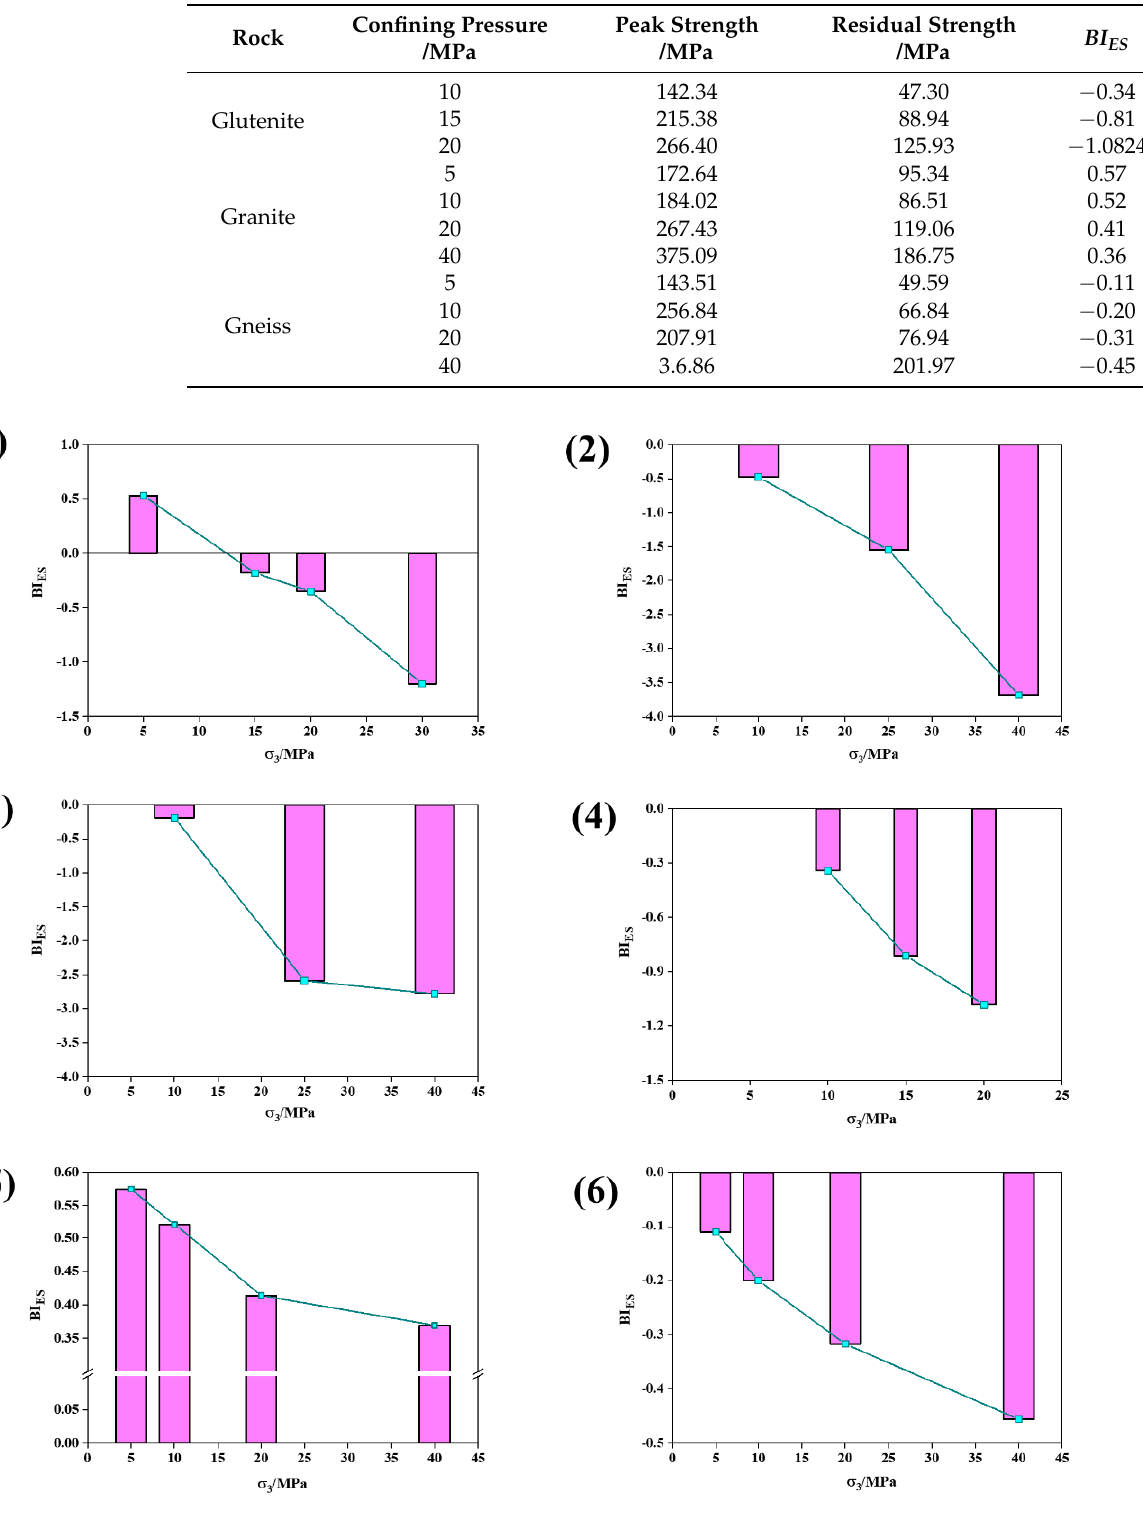
BI of six types of rocks: ( 1 ) Sandstone; ( 2 ) Shale 1; ( 3 ) Shale Figure 8. Calculation results of BI ES of six types of rocks: ( 1 ) Sandstone; ( 2 ) Shale 1; ( 3 ) Shale 2; Figure 8. Calculation results of ES ( 4 ) Glutenite; ( 5 ) Granite; ( 6 ) 2; ( 4 ) Glutenite; ( 5 ) Granite; ( 6 ) Gneiss .